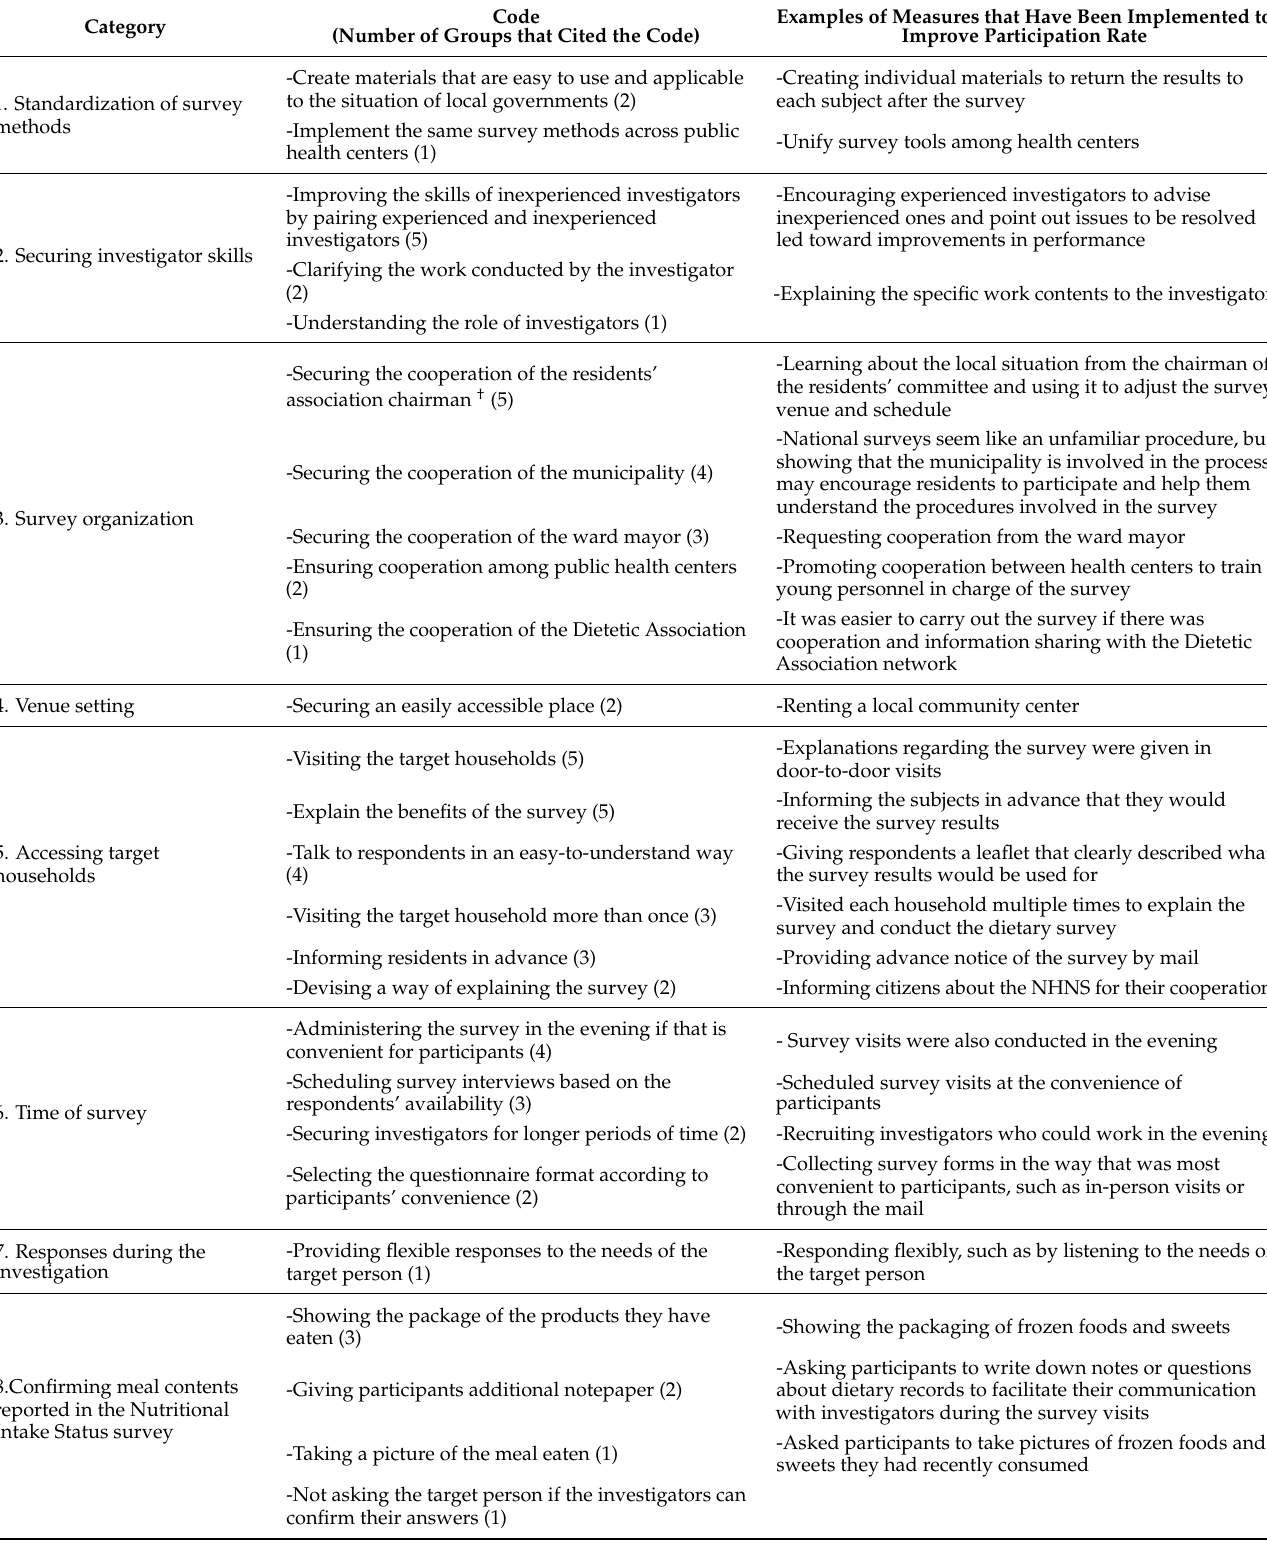
Table 4. Controllable measures to improve participation rates of the National Health and Nutrition